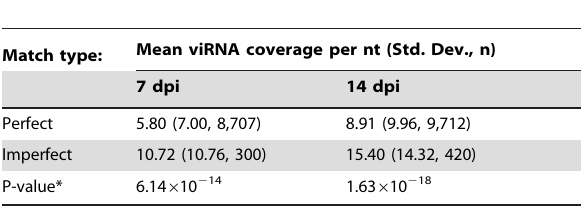
Table 2. Increased viRNA coverage of WNV genome at imperfectly aligned